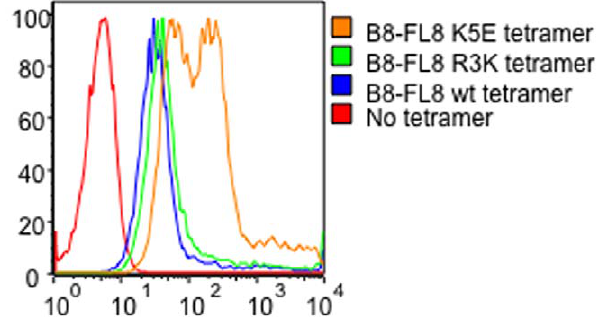
Figure 1. Representative flow cytometry dot plot reflecting binding of HLA-B8-FL8 wild-type and variant tetramers to CD14 + monocytes.